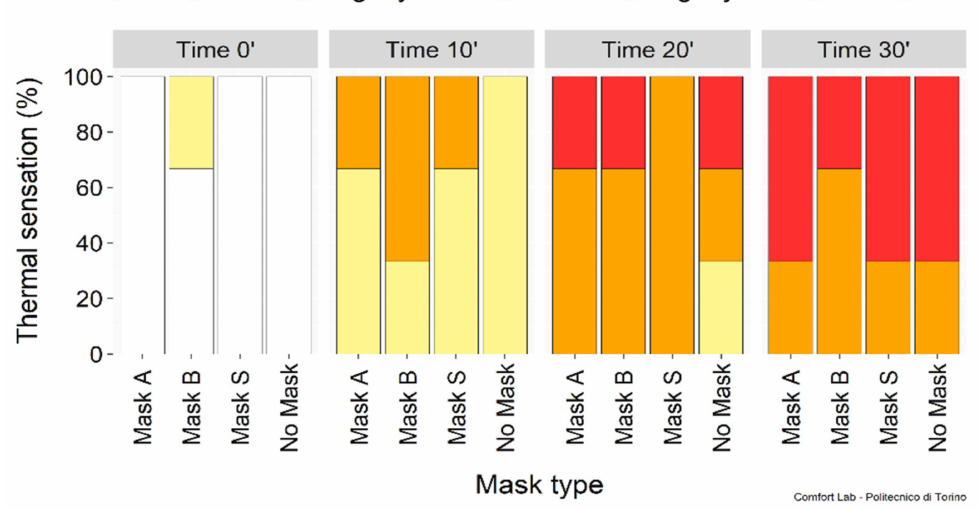
Figure 11. Perceived thermal sensation during the physical activity